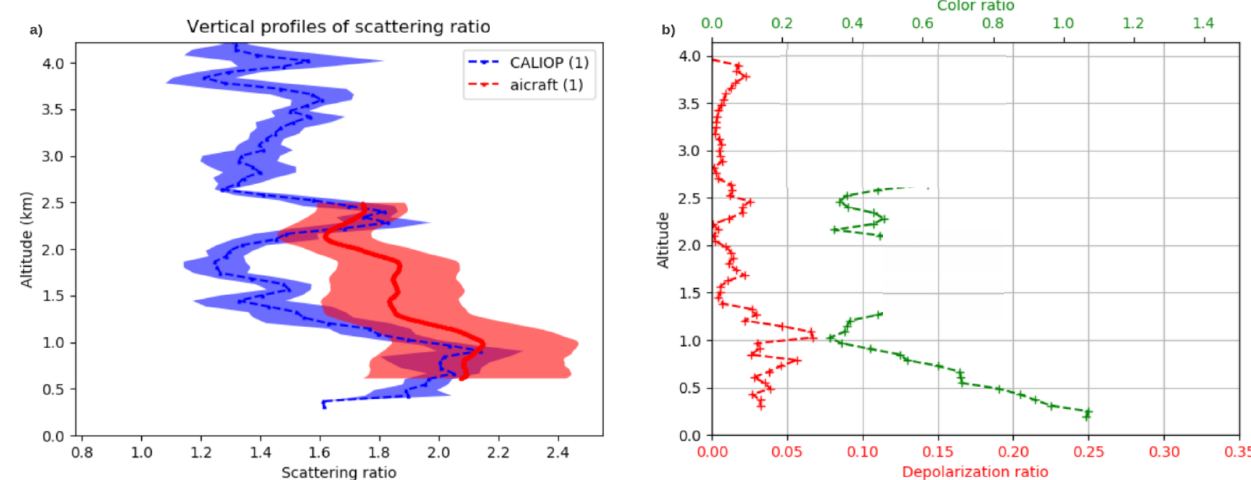
Figure 21. ( a ) Vertical profiles of 532 nm backscatter ratio for the aircraft lidar in red box of Figure 18a (red line) and for CALIOP on 17 July 2013 at 20 UT and 55.5 ◦ N (blue line), ( b ) Vertical profiles of the particle color ratio (green) and particle linear depolarization ratio (red) measured by CALIOP.